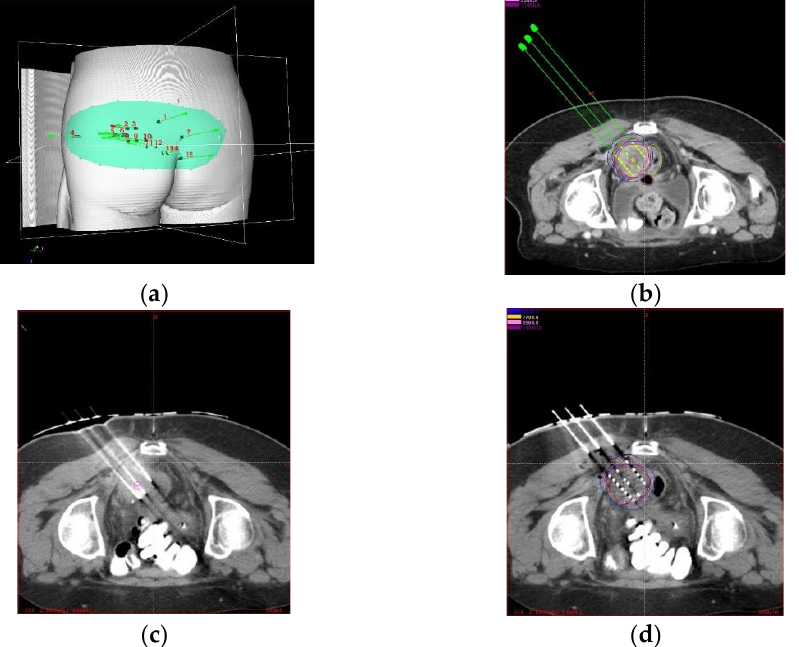
Figure 1. ( a ) 3D digital body-shaped template according to preoperative CT image. ( b ) pre-operative planning based on CT scan. ( c ) intraoperative and ( d ) postoperative validation based on CT scan.